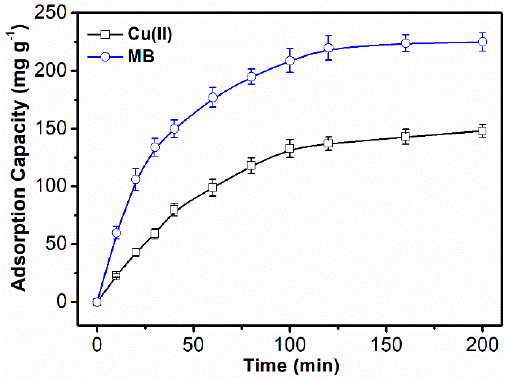
Figure 6. Adsorption kinetics curve of the adsorption of MB and Cu(II). Table 1. Kinetics parameters for the adsorption of MB and Cu(II).